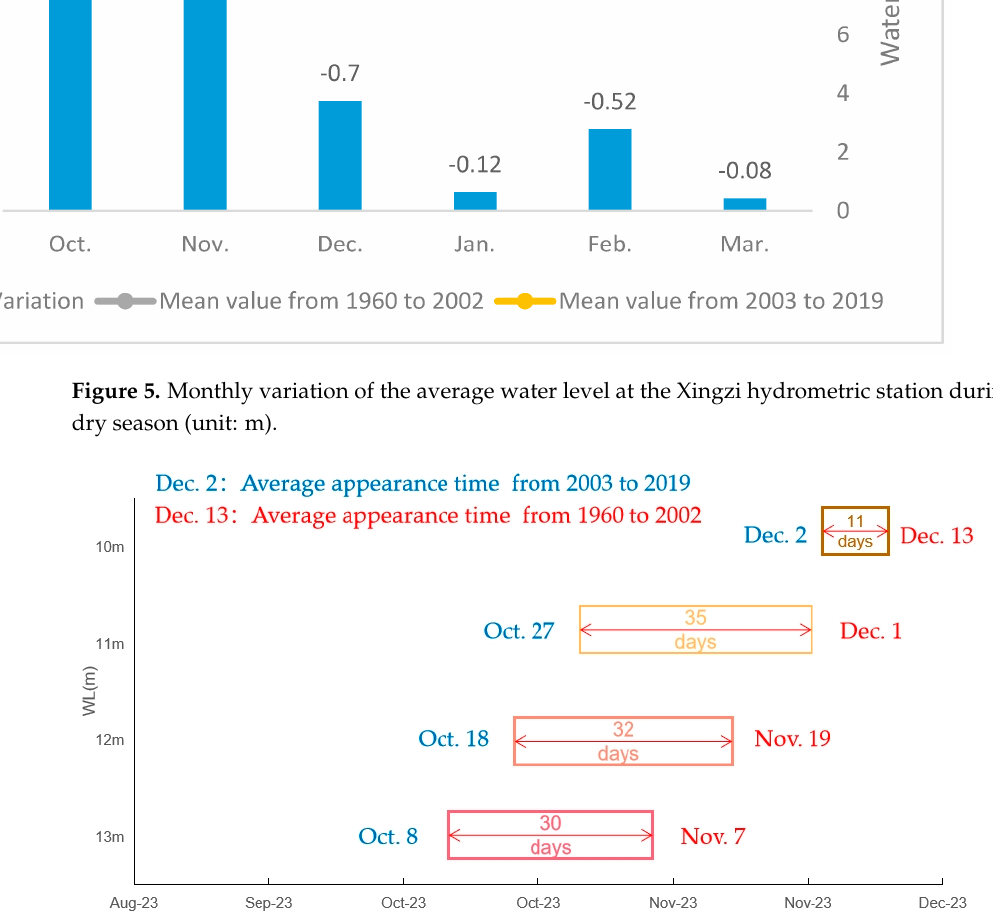
Figure 6. Comparison of average appearance times of different water levels at the Xingzi hydromet- ric station before and after operation of the Three Gorges Project.